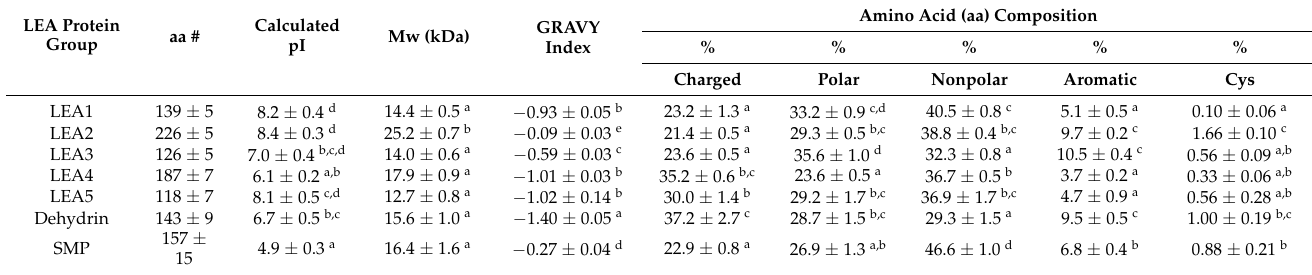
Table 2. Sequence-dependent characteristics of LEAPs from R. serbica . The physicochemical pa- rameters of each LEAP were calculated by using the ExPASy online server (http://web.expasy. org/compute_pi/, accessed on 8 February 2022) and by the GRAVY calculator (http://www.gravy- calculator.de/, accessed on 8 February 2022).